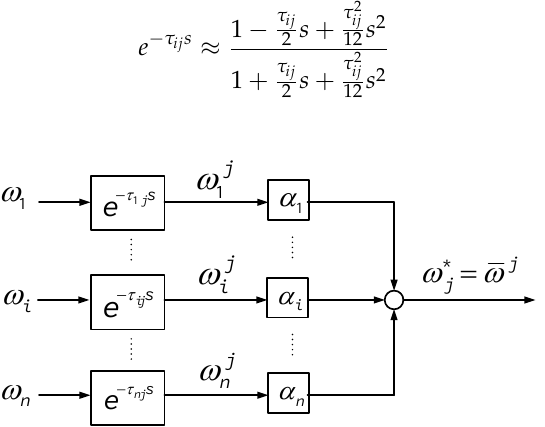
Figure 6. Calculation of the frequency set point of VSC j in the presence of communication latency.